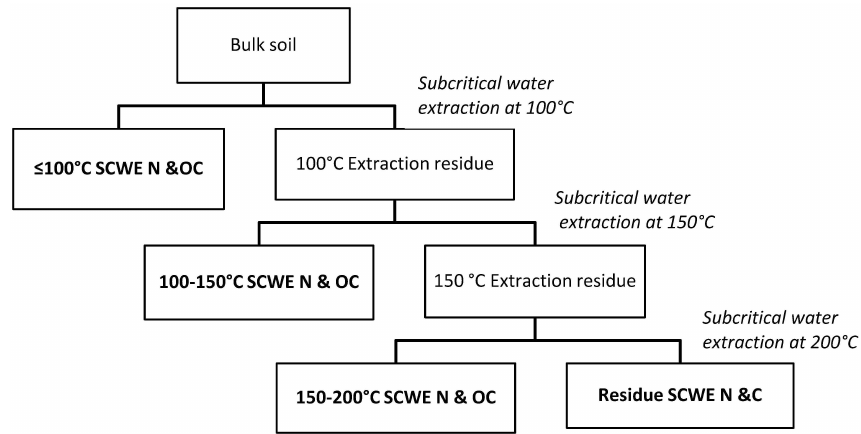
Fig. 1. Schematic of an experimental procedure for the sequential separation of subcritical water extracts. Extractions at 100, 150 and 200 ◦ C were made by means of an accelerated solvent